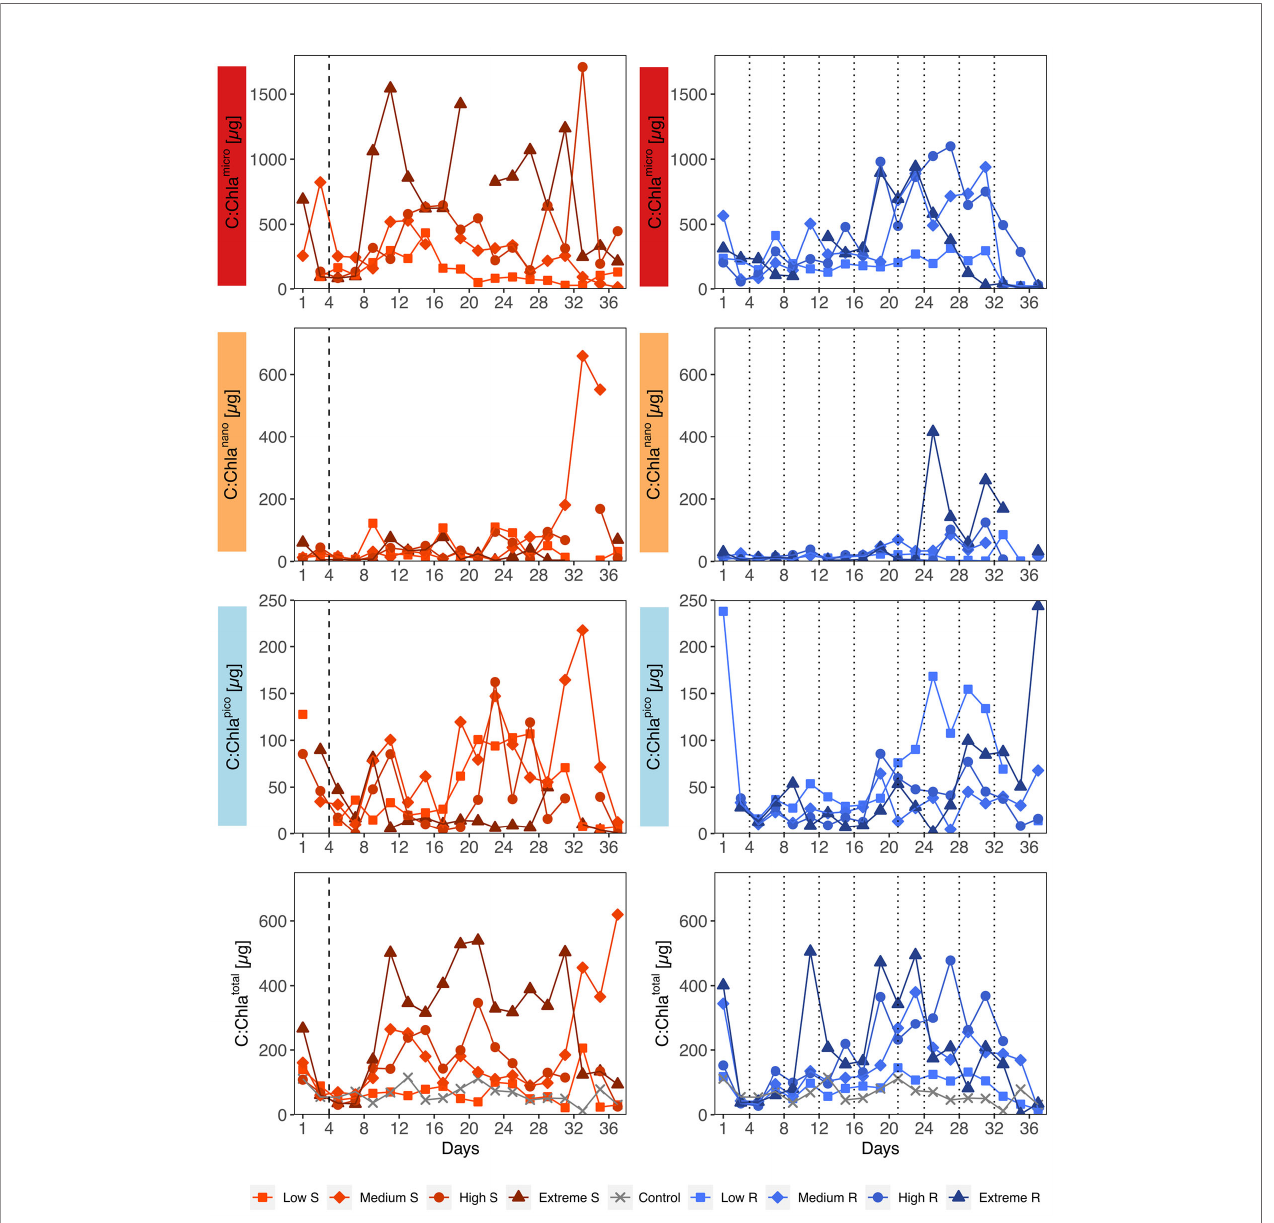
FIGURE 5 | Temporal development of carbon to chlorophyll ratios (C:Chla) separated by size fractions and upwelling mode. S, Singular; R, Recurring. Mind the different y-axis scales. Dotted lines represent DW additions, dashed line marks the single DW addition to singular